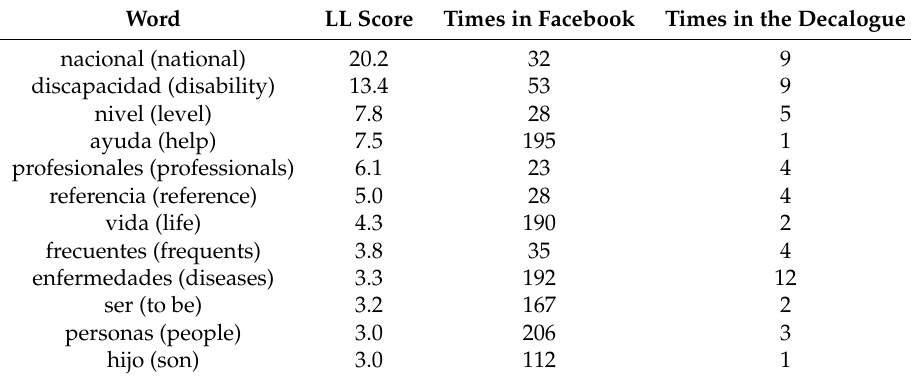
Table 3. Top 12 words with the highest LL